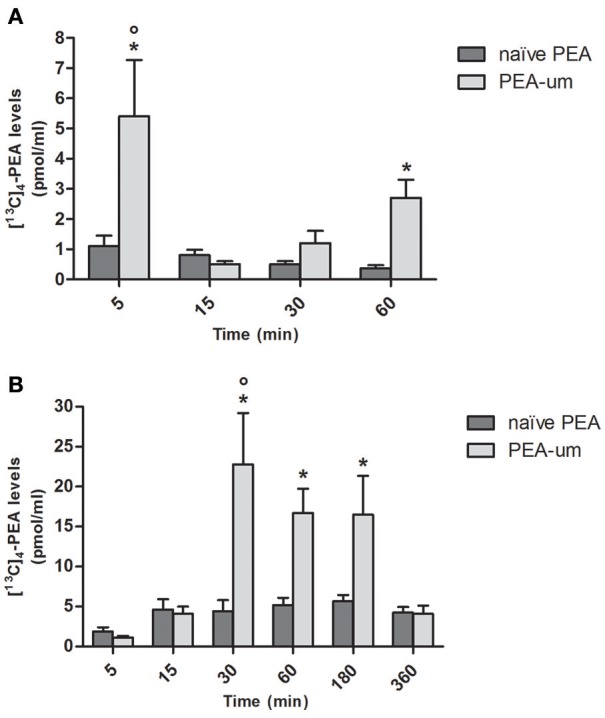
Effect of ultramicronization on plasma levels of [13C]4-PEA in healthy and CAR-injected rats. Levels of [13C]4-PEA in plasma of healthy (A) and CAR-injected (B) rats 5, 15, 30, 60, 180, and 360 min after oral administration of 30 mg/kg [13C]4-PEA-um or naïve [13C]4-PEA. Data are means ± SEM of five animals for each group. *P < 0.05 vs. baseline; °P < 0.05 vs. naïve PEA.